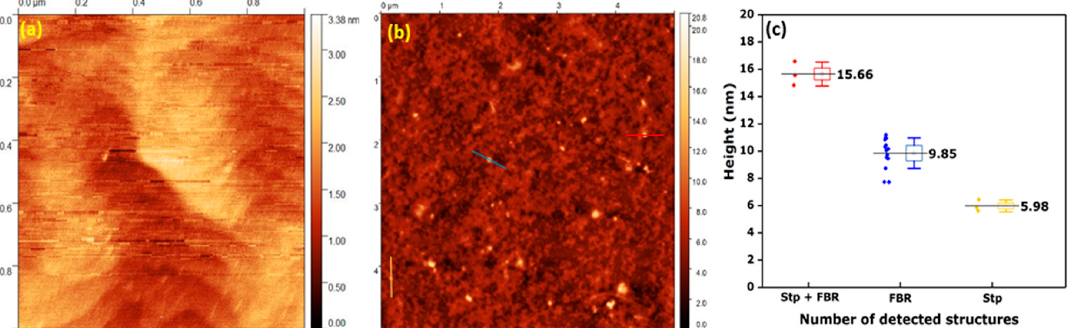
Figure 6. AFM images of ( a ) bare and ( b ) protein functionalized p-GaN ( A ). ( c ) Height distribution of bright features on the coated p-GaN ( A ) surface. Nanostructures were clustered according to their dimensions, and three different clusters were identified with about 6 nm, 9.9 nm and 15.7 nm, which were assigned to Stp (5 nm), FBR complexes (10 nm) and Stp bound FBR complexes (15 nm).